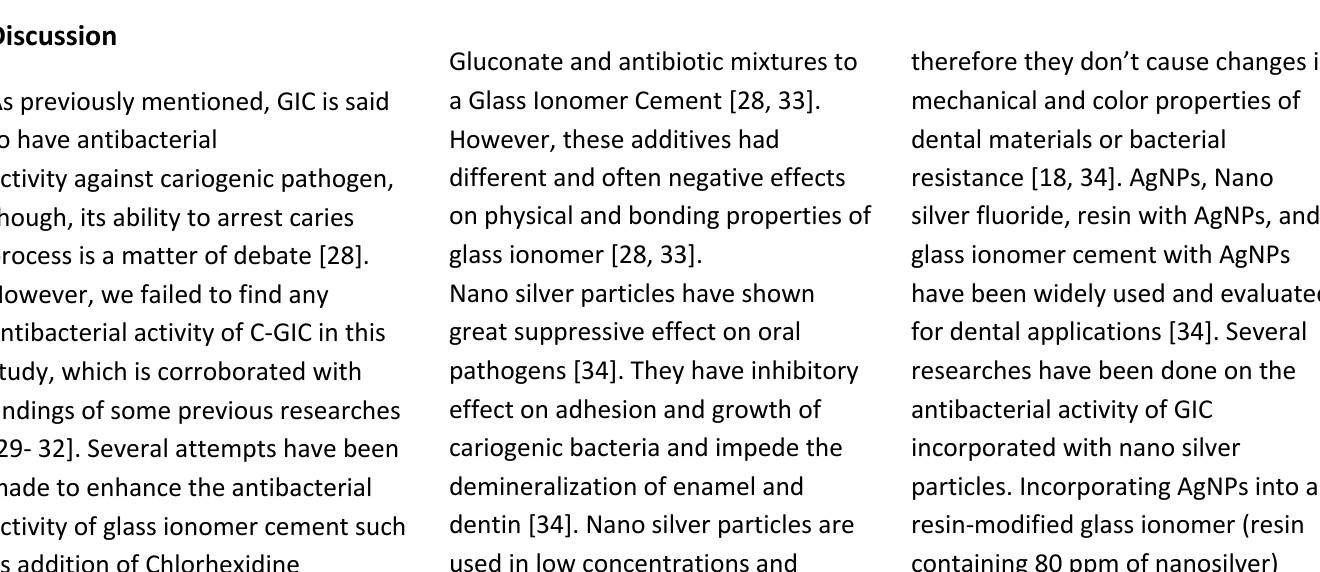
*Indicates the results of Independent-samples t-test for comparison of the antibacterial effect of the two disks against each bacterial